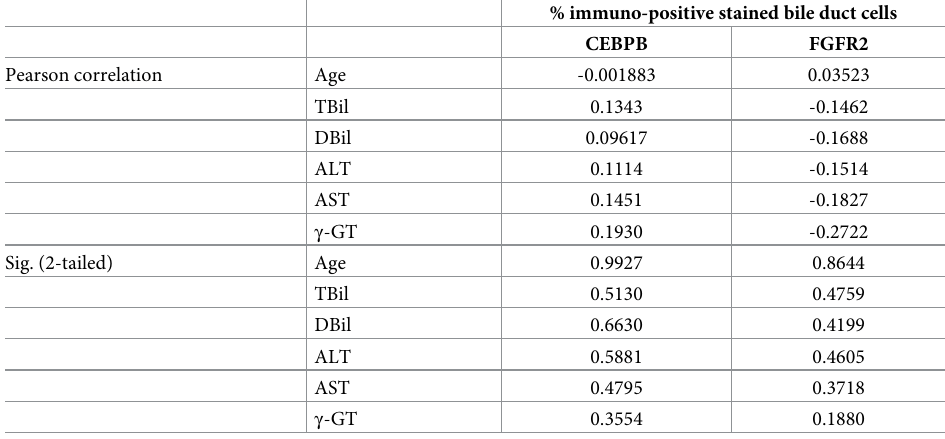
Table 3. Correlation analysis of FGFR2 and CEBPB immuno-reactivity and clinical